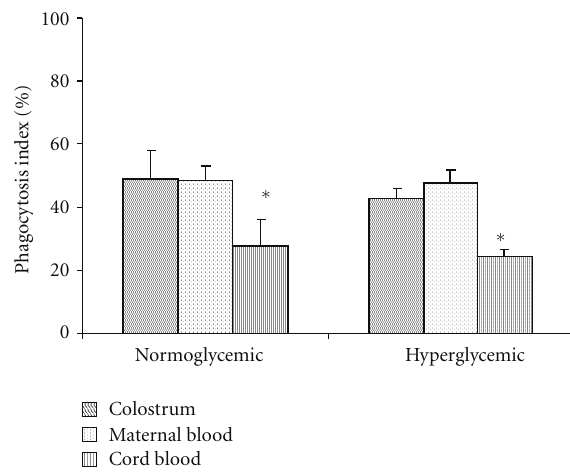
Figure 2: Mean ( ± SD) bactericidal index of colostrum, maternal, and cord blood MN cells ( N = 10) determined using the acridine orange method. ∗ Indicates statistical di ff erence ( P < 0 . 05) within normo- and hyperglycemic